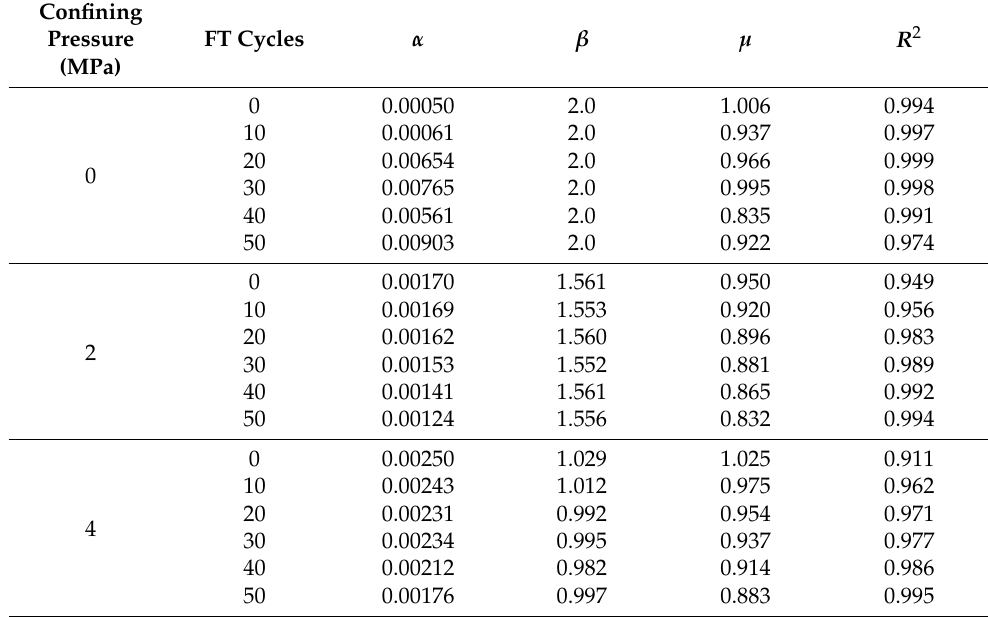
Table 2. Fitting parameters ( α , β , and µ ) and coefficient of determination ( R 2